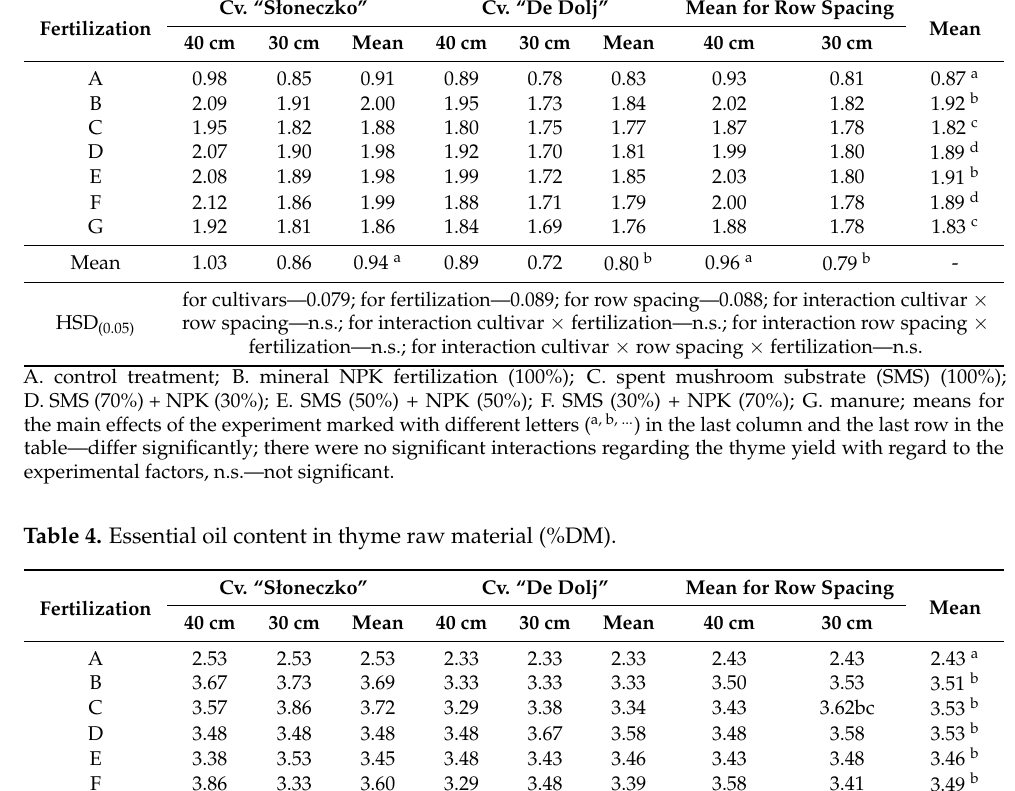
Table 3. Yield of air-dry weight of thyme (t ha − 1 ). Fertilization